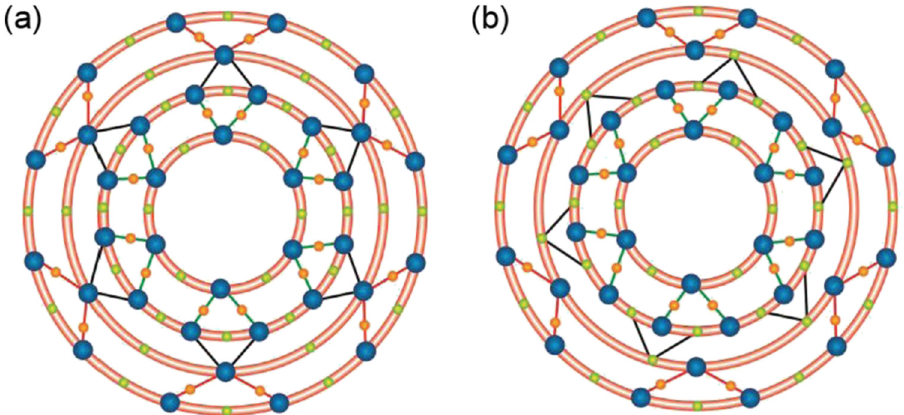
Figure 1: First ( a ) and second ( b ) metal - organic frameworks of dimension 2.